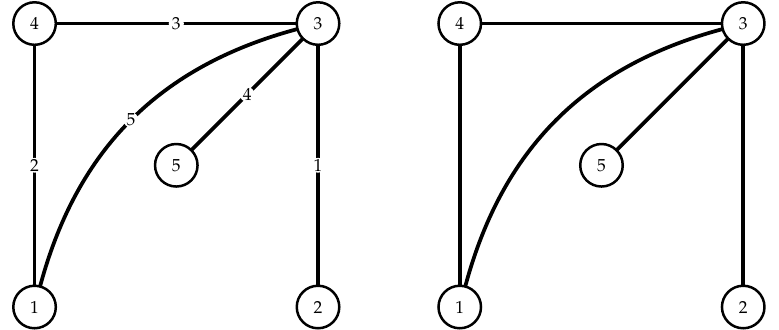
Figure 1. An example of temporal graph with five nodes and five temporal edges ( left ), and the corresponding "non-temporal” graph in which edge temporal labels have been removed (right